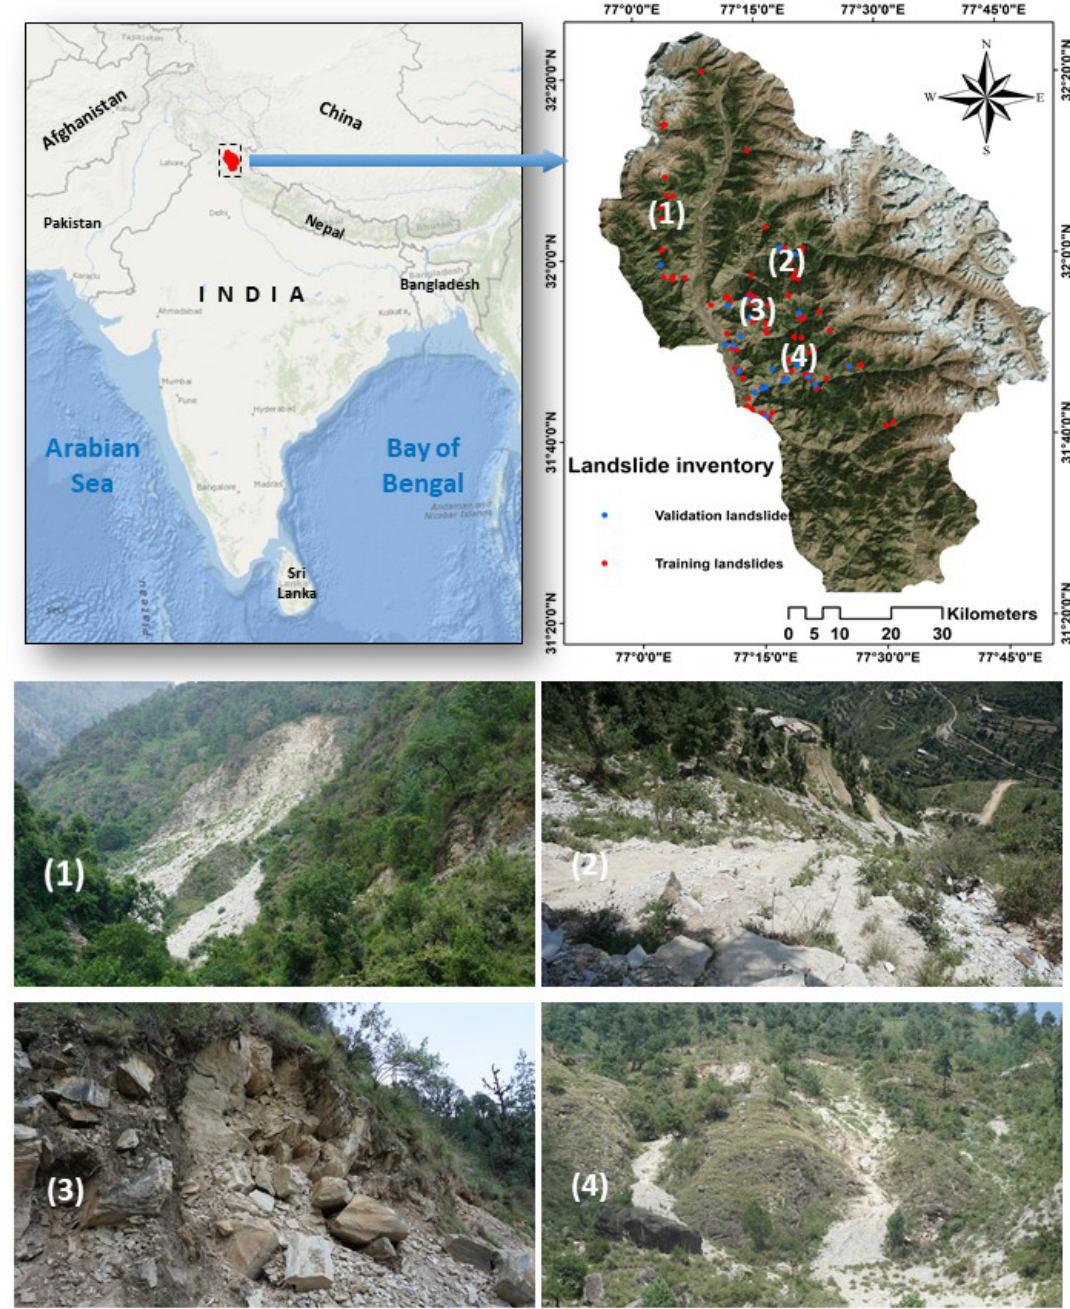
Figure 1. Map showing the location of the study area, landslide inventory map with the distribution of training and validation datasets, and field photographs: ( 1 ) debris slide, ( 2 ) debris slide, ( 3 ) rockfall, and ( 4 ) debris